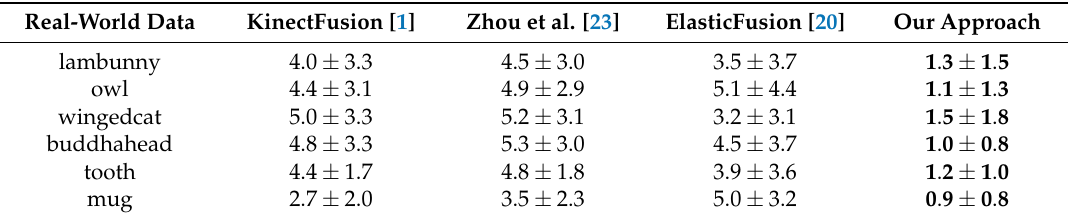
Table 4. Surface Reconstruction accuracy on our real-world data, with C2M error metric ( Mean ± Std. ) in millimeters. Note that for real-world data, the evaluation is only performed on the 3D printed objectives but not the whole scene.